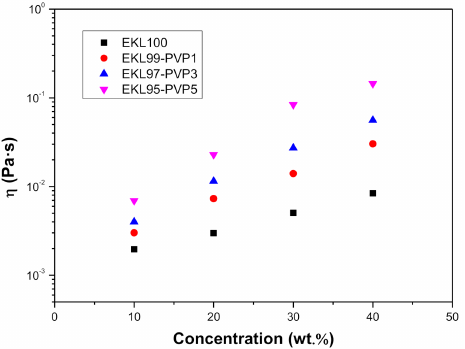
Figure 1. Shear viscosity of EKL/PVP solutions in DMF as a function of total polymer concentration and EKL:PVP